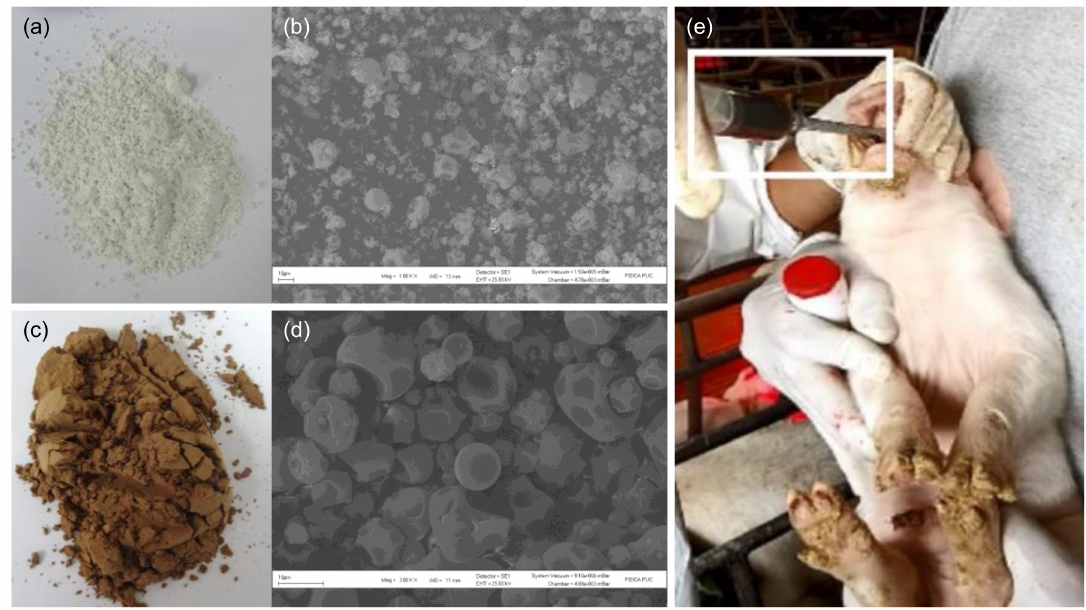
Figure 1. Scanning electron micrograph showing the appearance and morphology of ferrous sulphate (FS) microparticles ( a ) and ( b ) and bovine erythrocytes (BE) microparticles ( c ) and ( d ), respectively. Appearance of the encapsulated supplement and delivery method used with piglets ( e ).